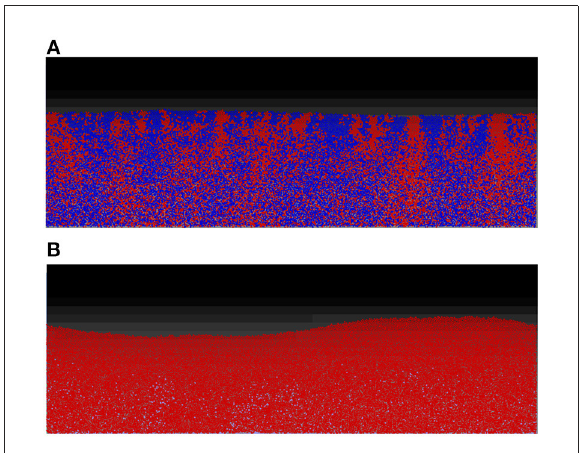
FIGURE4 A parameter map showing the optimal, evolutionary stable, growth strategy (aggressive vs. no toxin production) under different combinations of toxin killing rate and initial nutrient concentration. For a constitutive toxin producer, aggression is favored as the initial nutrient concentration and the toxin lethality increase. Peaceful growth conversely is the optimal growth strategy when nutrients are more limited and the toxin is less lethal. A third, narrower, parameter region exists which is characterized by the existence of multiple evolutionary stable growth strategies.